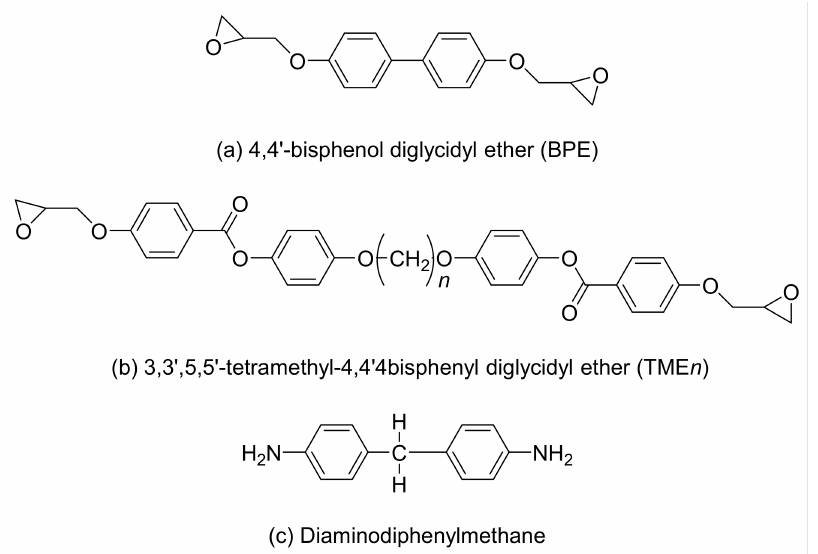
Figure 5. Molecular structures of ( a ) 4,4 (cid:48) -biphenol diglycidyl epoxy (BPE), ( b ) 3,3 (cid:48) ,5,5 (cid:48) -tetramethyl- 4,4 (cid:48) 4bisphenyl diglycidyl ether (TME n ) ( n = 4, 6, 8), and ( c ) diaminodiphenylmethane